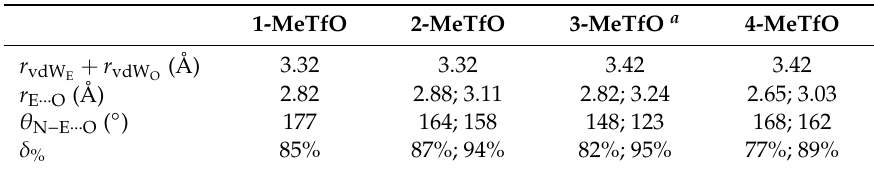
Table 2. Comparison of the sums of van der Waals radii, length ( d ), valence angles ( θ ) and parameters δ % of ChBs occurring in the crystal structures of the triflates (double values refer to two interactions di ff ering in energy).